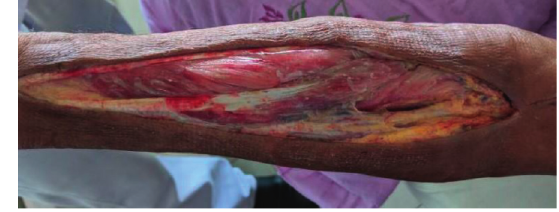
Figure 2: Left arm following